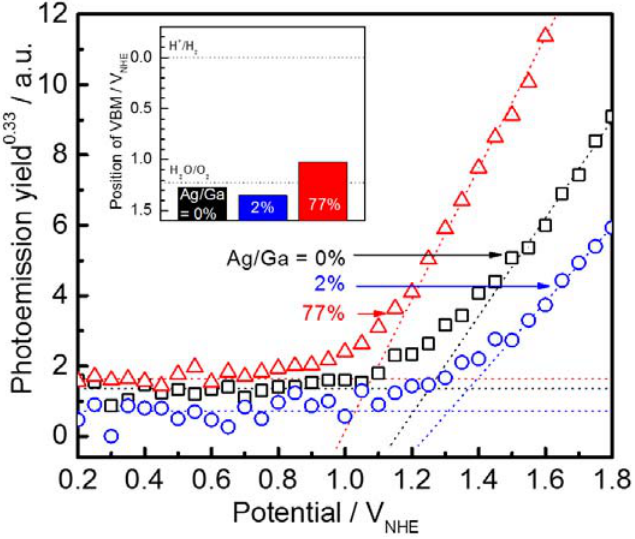
Figure 9. PESA spectra of the prepared AGSe with different Ag/Ga ratios and VBM